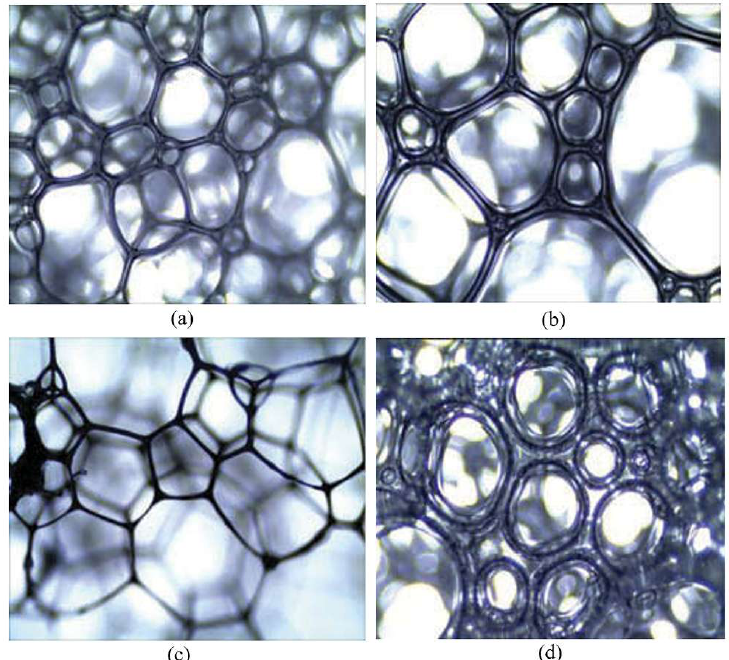
Figure 16. The microstructure maps of multi-phase foamed gel: ( a ) Without thickener and crosslinker; ( b ) only with thickener; ( c ) only with crosslinker; ( d ) both thickener and crosslinker [64].